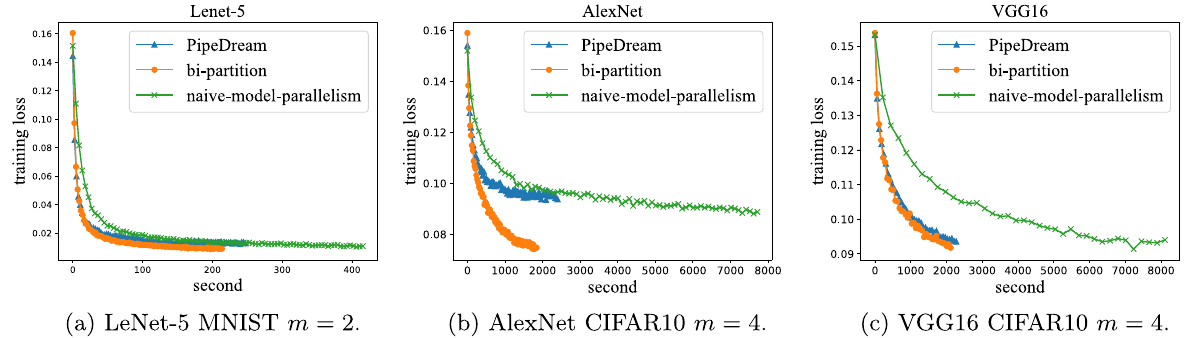
Fig. 10 Training Loss vs. Training time on LeNet-5, AlexNet and VGG16 compared to naive-model-parallelism and